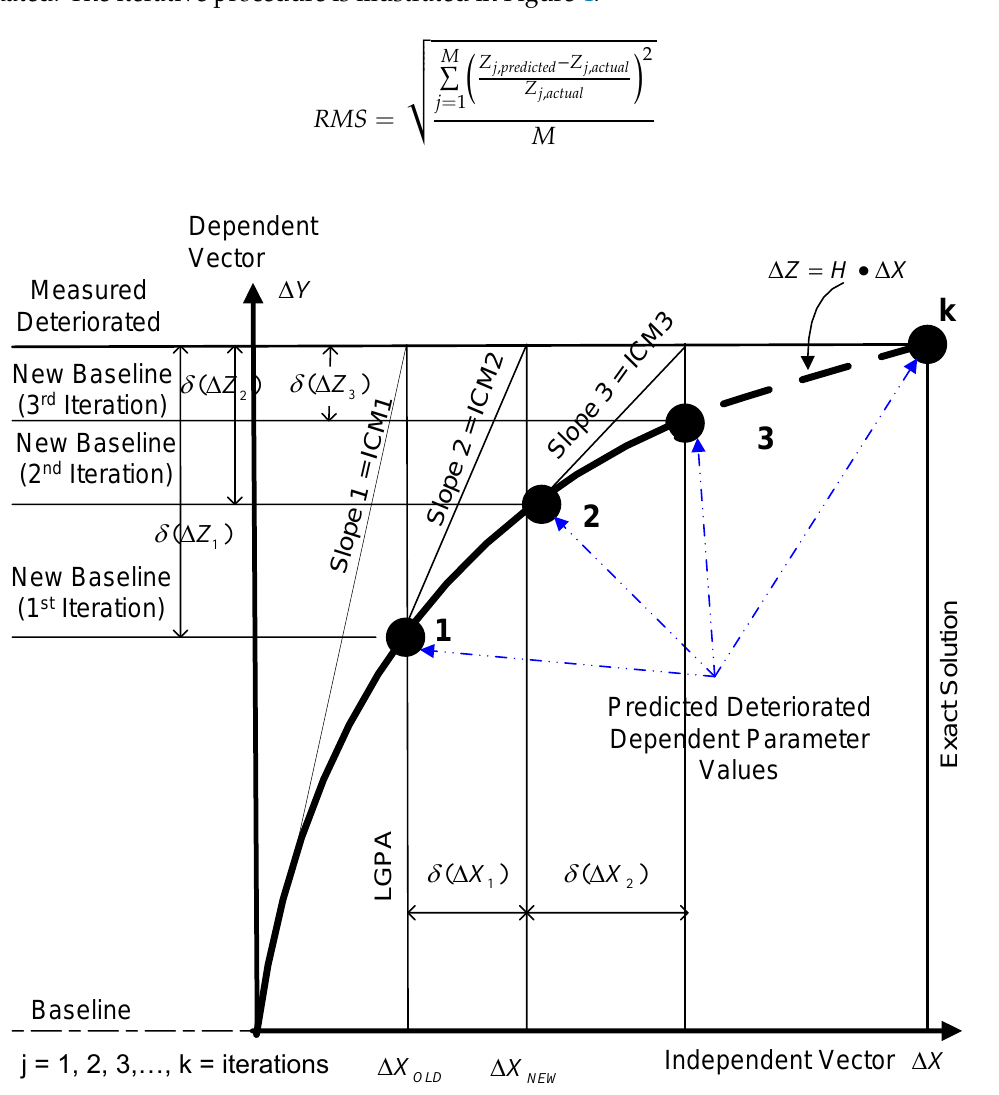
Figure 4. Schematic illustration of Newton-Raphson based on gas path analysis (GPA) methods (adapted from [104]).